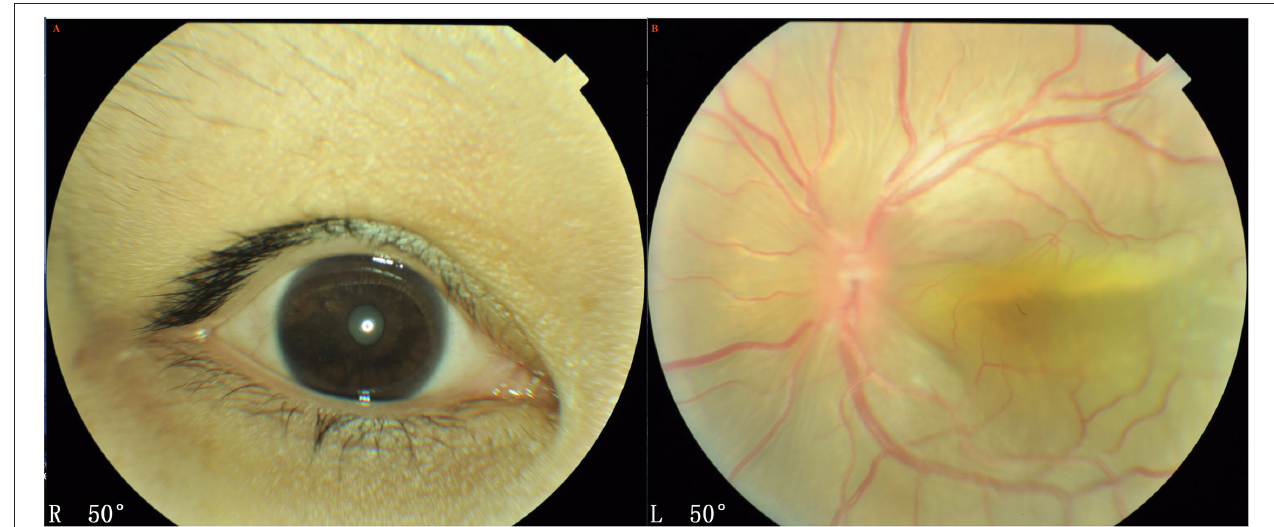
FIGURE 3 | UES in Type 1. (A) FFA (Spectralis; Heidelberg Engineering, Inc.) revealed the retinal vein dilation with leopard-spot sign of granular hyperfluorescence of the retinal pigment epithelium (RPE) was observed in the posterior pole and inferior quadrants. (B) ICGA revealed diffusely granular marked choroidal hyperfluorescence at the early stage, which increased with time and persisted until the late stage as diffuse intense choroidal hyperfluorescence.